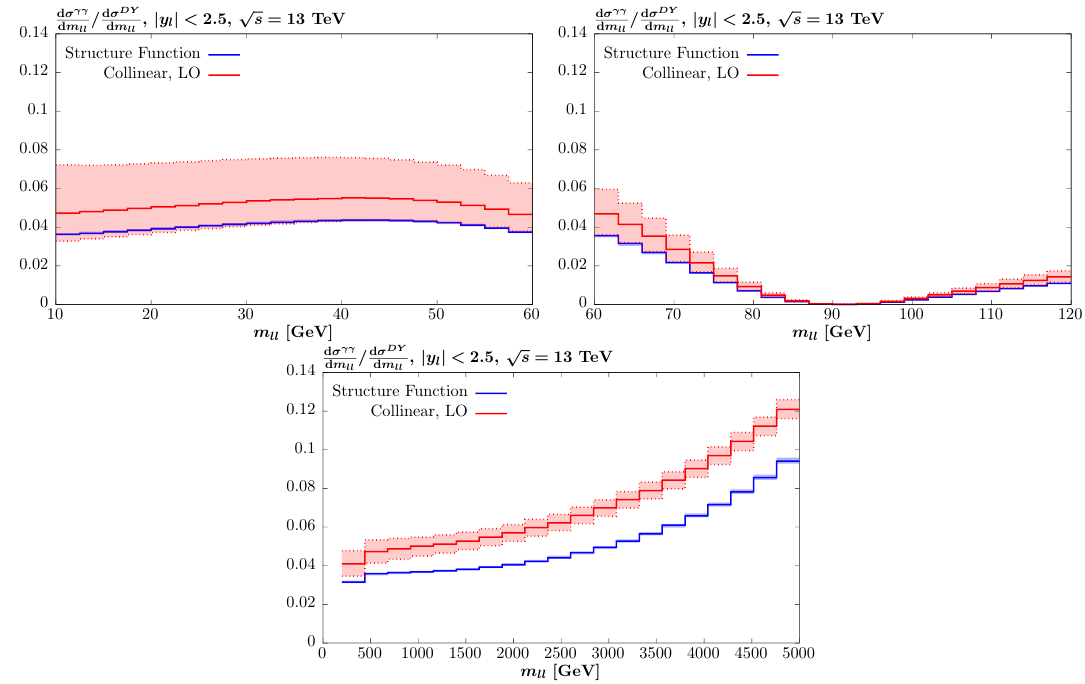
Figure 5 . Ratio of the photon-initiated cross sections for lepton pair production production to the NLO QCD Drell-Yan cross section at the 13 TeV LHC, as a function of the lepton pair invariant mass, m ll . The LO collinear predictions and the more precise structure function result, using (2.1) directly, are shown. In the former case the uncertainty band due to factorization scale variation by a factor of two around the central value (cid:22) = m ll , is given. The leptons are required to lie in the j (cid:17) l j < 2 : 5 region. In the latter case, the error band due to the experimental uncertainty on the on the structure functions is shown (note in some regions this is comparable to the line width of the central